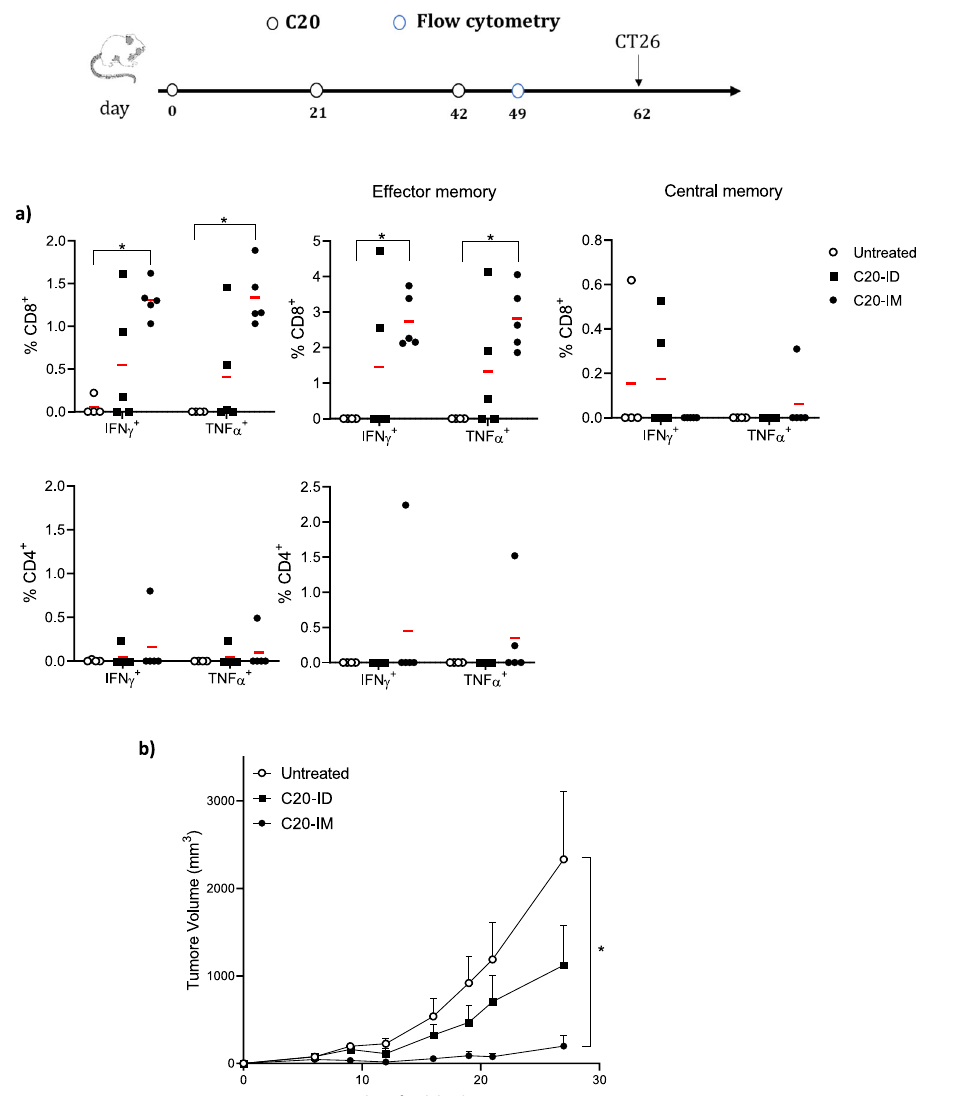
Fig. 3 Prophylactic C20-IM induces a signi fi cant reduction in tumor growth. a Balb/c mice were vaccinated with the C20 vaccine at days 0, 21, and 42 and challenged with CT26 cells on day 62. One week after the last immunization (day 49), mice were bled retro-orbitally to monitor T cell immune response against CT26-neoepitopes by intracellular staining. Panel describes CD8 and CD4 neoantigen-speci fi c effector and central memory T cell responses measured by FC using the gating strategy depicted in Supplementary Fig. 2. The stimulation pool included the 15 peptides listed in Table 2. b The panel depicts CT26 tumor growth overtime of one out of two experiments performed. Five animals per group were utilized. Each symbol represents an individual sample with the error bars representing the s.e.m. Signi fi cance was determined using Mann – Whitney test (* p <